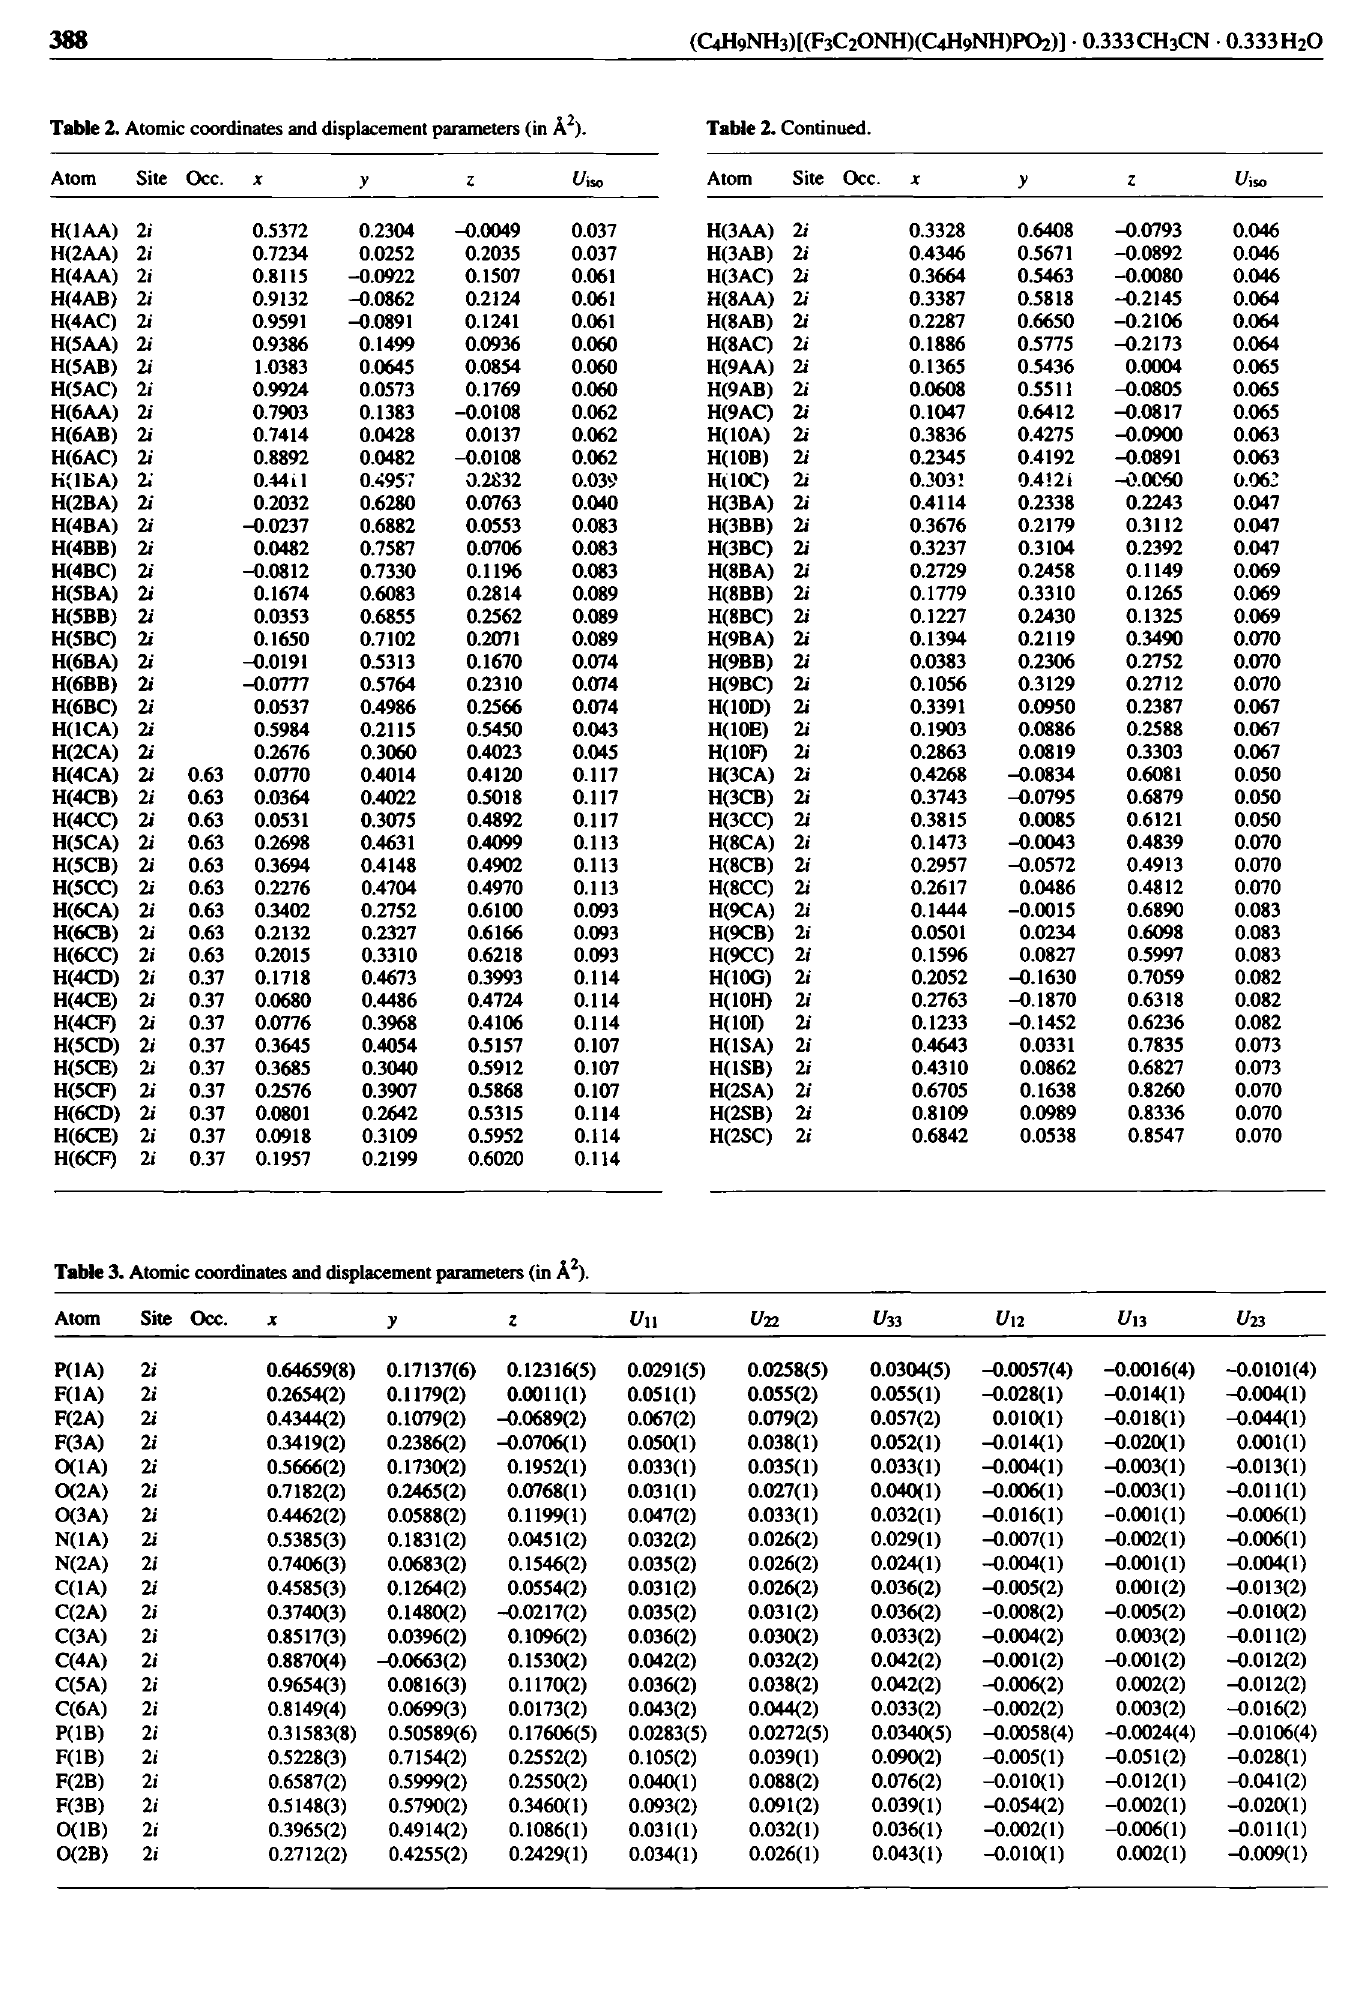
Table 2. Atomic coordinates and displacement parameters (in A 2 ). Table 2. Continued.